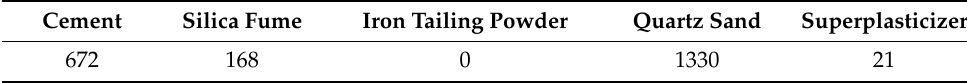
Table 3. Mix proportion of the reference sample (kg/m 3 ).